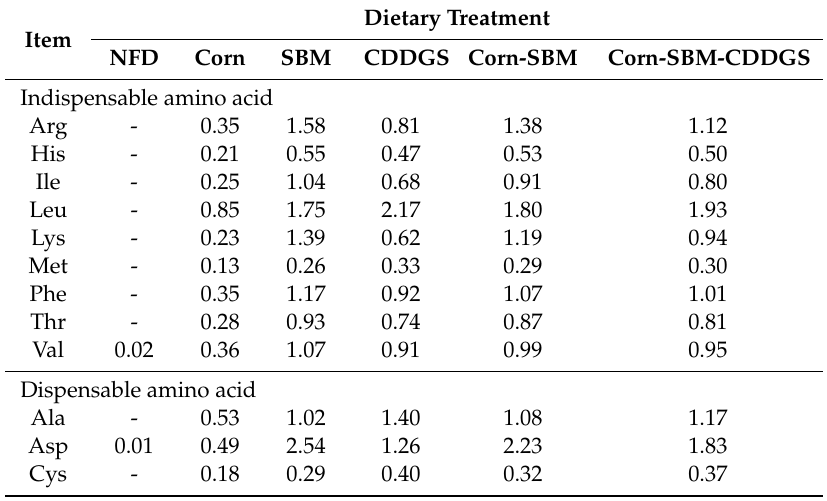
Table 3. Analyzed amino acids composition of the experimental diets (%, as-fed